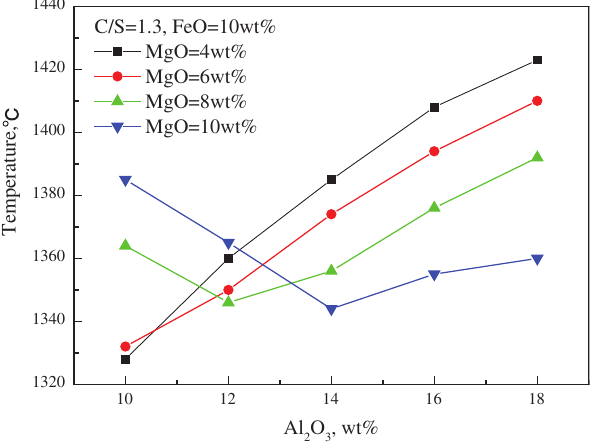
Figure 4: T LQ of CaO – SiO 2 – Al 2 O 3 – MgO – 10 wt% FeO slags as a function of Al 2 O 3